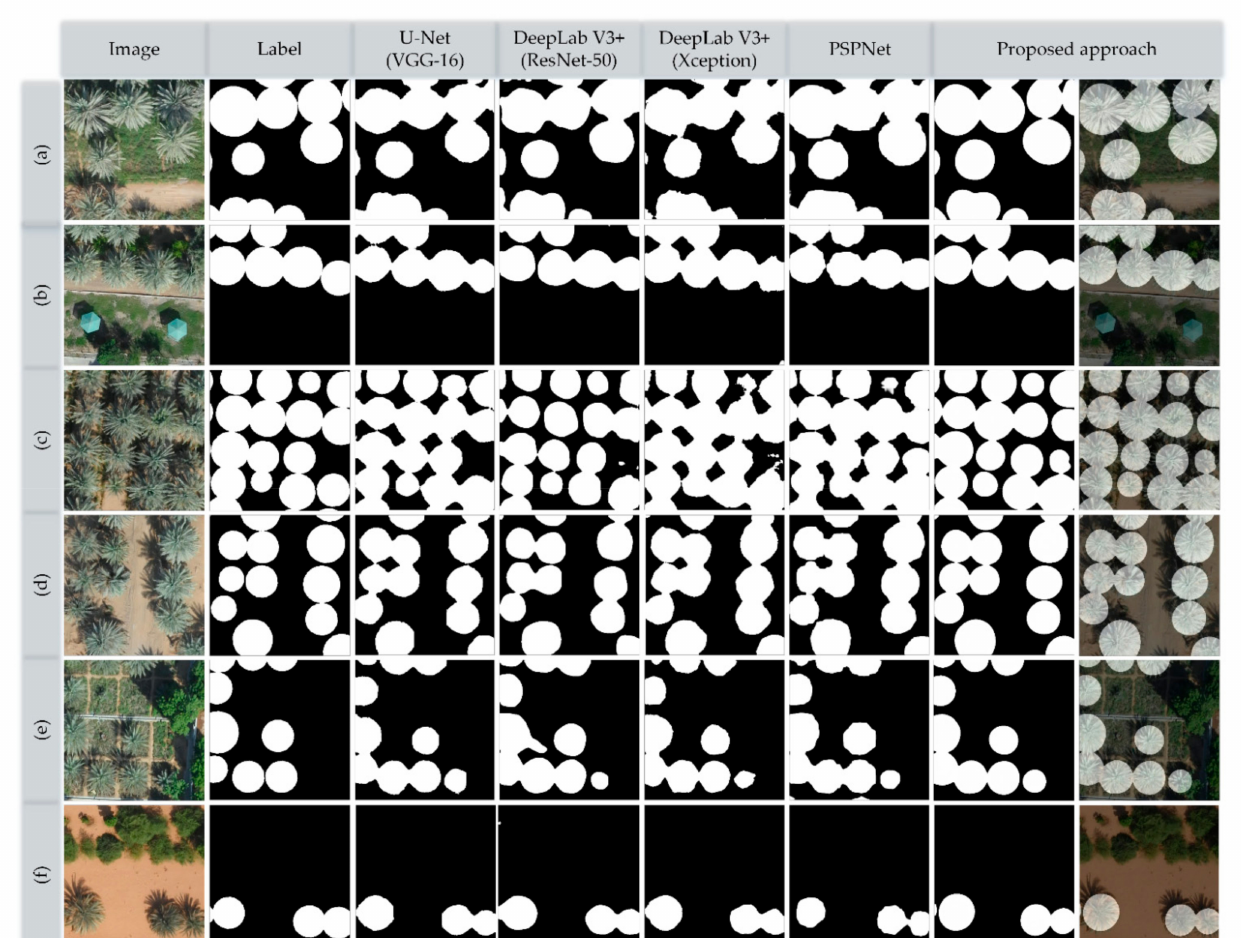
Figure 9. Comparison of six randomly selected images ( a – f ) from the validation dataset and their corresponding seg- mentation results. The left column shows the selected RGB images, followed by the corresponding ground truth label, and segmentation results of the evaluated models including U-Net (based on VGG-16 network), DeepLab V3+ (based on